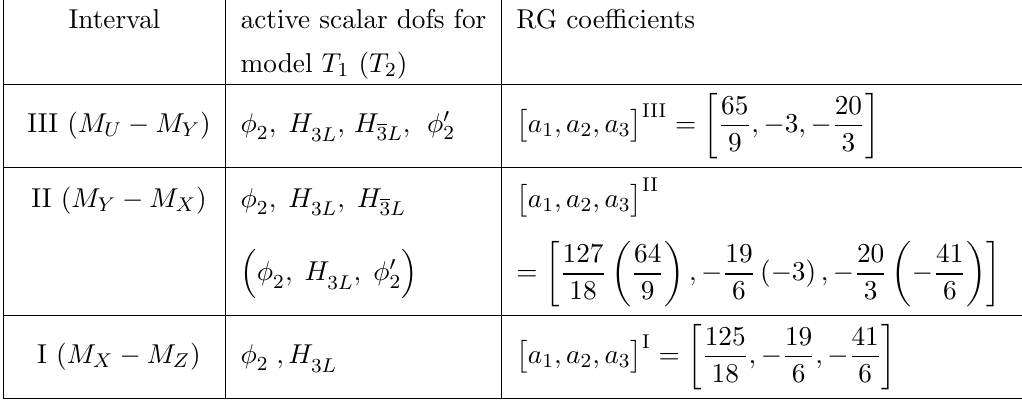
Table 4 . The Higgs content and the RG coe(cid:14)cients in the energy intervals for model T 1 ; 2 . Recall that all the (cid:12)elds above are